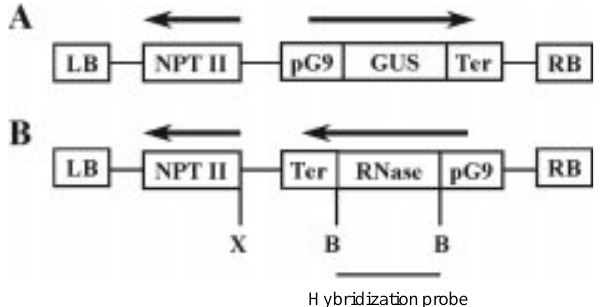
Figure 1 - Diagram of the T-DNA region of the Agrobacterium tumefaciens vectors used for tobacco transformation. The vectors contained the chi- meric genes G9- GUS ( G9 promoter fused to GUS reporter gene) ( A ) or G9- RNase ( G9 promoter fused to the rat RNase coding region) ( B ). The sites for the restriction endonucleases Bam HI (B) and Xba I (X) and the DNA fragment used as the hybridization probe in Southern blots are shown. Neomycin phosphotransferase ( NPT II) was used as a marker. LB, RB, T- DNA left and right borders, respectively.